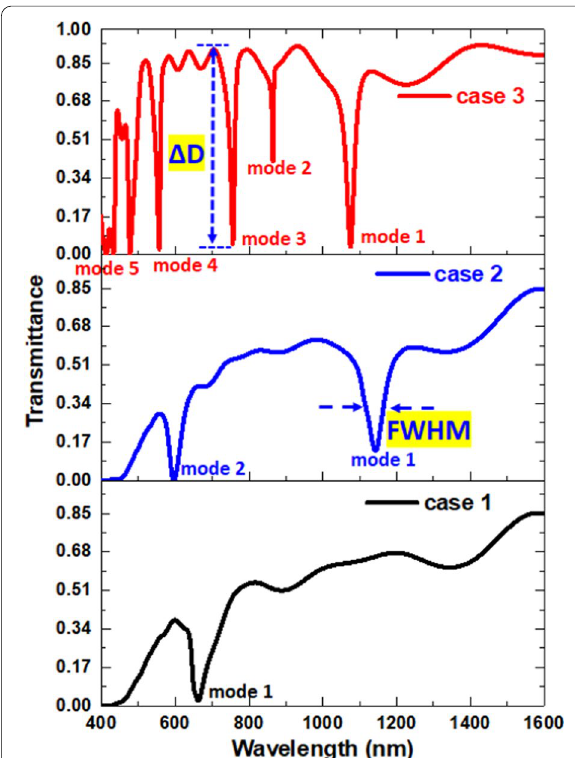
, FWHM, S, FOM, ΔD, and QF of cases res